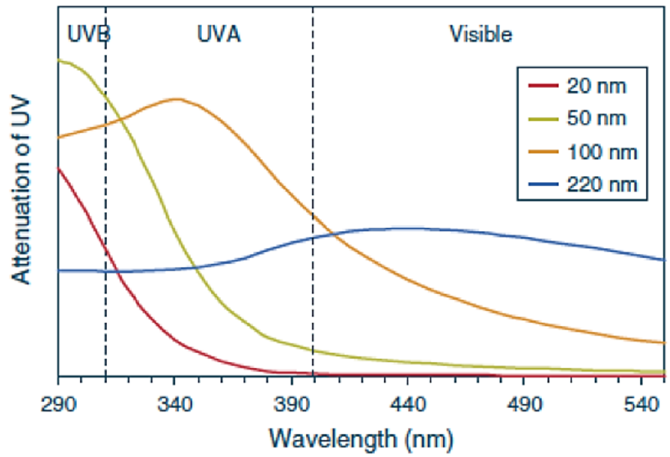
Figure 3. Effect of particle size on the UV attenuating properties of titanium dioxide. Reduction of particle size moves the peak of UV attenuation to shorter wavelengths, while improving transparency (Sligtly modified from [36], with permission from Allured.